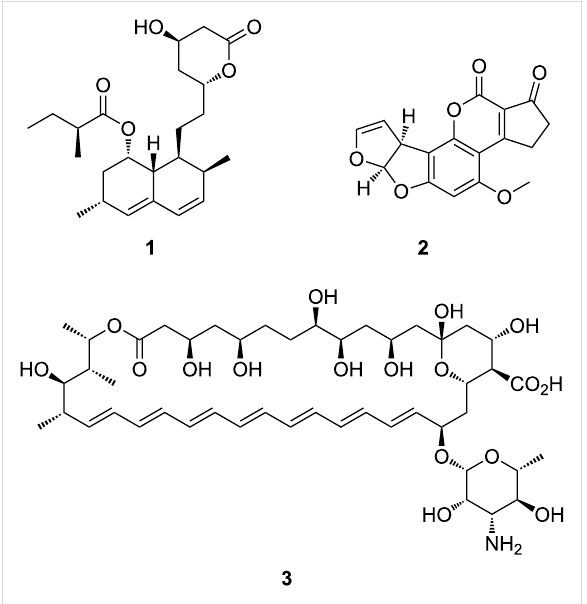
Figure 1: Structures of lovastatin ( 1 ), aflatoxin B 1 ( 2 ) and ampho- tericin B ( 3